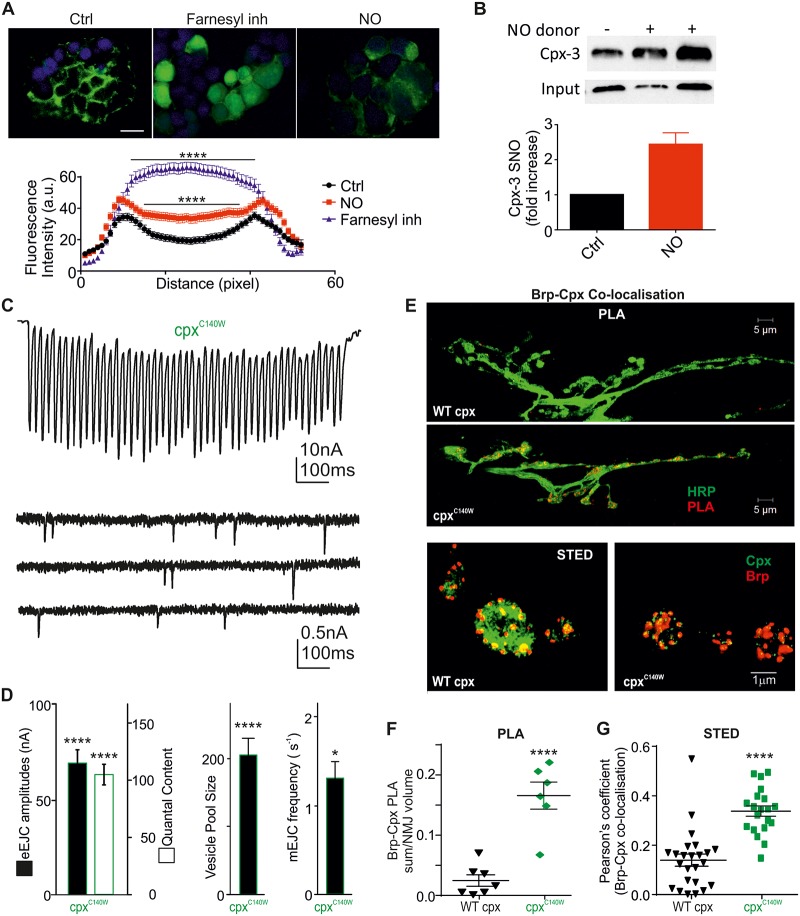
Cpx nitrosylation and block of farnesylation leads to redistribution of GFP-CAAX and enhances Dmcpx localization at AZs.(A) GFP-CAAX expression in HEK cells showing membrane fluorescence signals in Ctrls. Pharmacological inhibition of farnesylation by GGTI-298 + L-744,832 (“farnesyl inh,” p < 0.0001 versus Ctrl, ANOVA) and NO incubation (p < 0.0001 versus Ctrl, ANOVA) result in a redistribution of GFP fluorescence into the cytosol. Fluorescence signals were analyzed by line scan and plotted as intensities (a.u.) over distance across the cell somata, n = 80–104 cells, scale bar: 20 μm. (B) Mouse cpx-3 is S-nitrosylated in response to NO donor application. Immunoblot intensities increased 2.4 ± 0.5-fold following NO application. (C) Representative recordings of a 50-Hz train and spontaneous activity of a larva expressing Dmcpx 7AC140W with mean eEJC amplitudes, QC, vesicle pool size, and mEJC frequency shown in (D). (E) Top, maximal projection confocal images of NMJs expressing a WT cpx or Dmcpx 7AC140W showing the PLA signal in red; bottom, STED images showing cpx and Brp staining in WT and Dmcpx 7AC140W mutants. (F) Analysis of PLA data. (G) Co-localization data with Pearson’s coefficient for interactions of cpx with Brp. The raw data can be found in S8 Data. Data denote mean ± SEM, Student t test (D, F), *p < 0.05, ***p < 0.001, ****p < 0.0001. a.u., arbitrary unit; AZ, active zone; Brp, Bruchpilot; cpx, complexin; Ctrl, control; eEJC, evoked EJC; EJC, excitatory junction current; GFP, green fluorescent protein; HEK, human embryonic kidney; HRP, horseradish peroxidase; mEJC, miniature EJC; NMJ, neuromuscular junction; NO, nitric oxide; PLA, proximity ligation assay; QC, quantal content; STED, stimulated emission depletion; WT, wild-type.